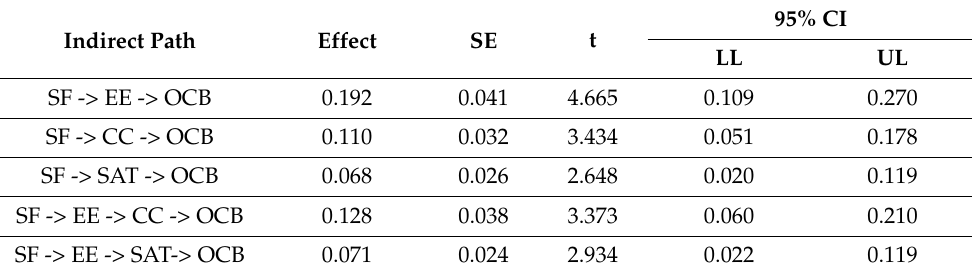
Table 3. Indirect influence transmitted through employee engagement, organizational commitment and job satisfaction using the bootstrap